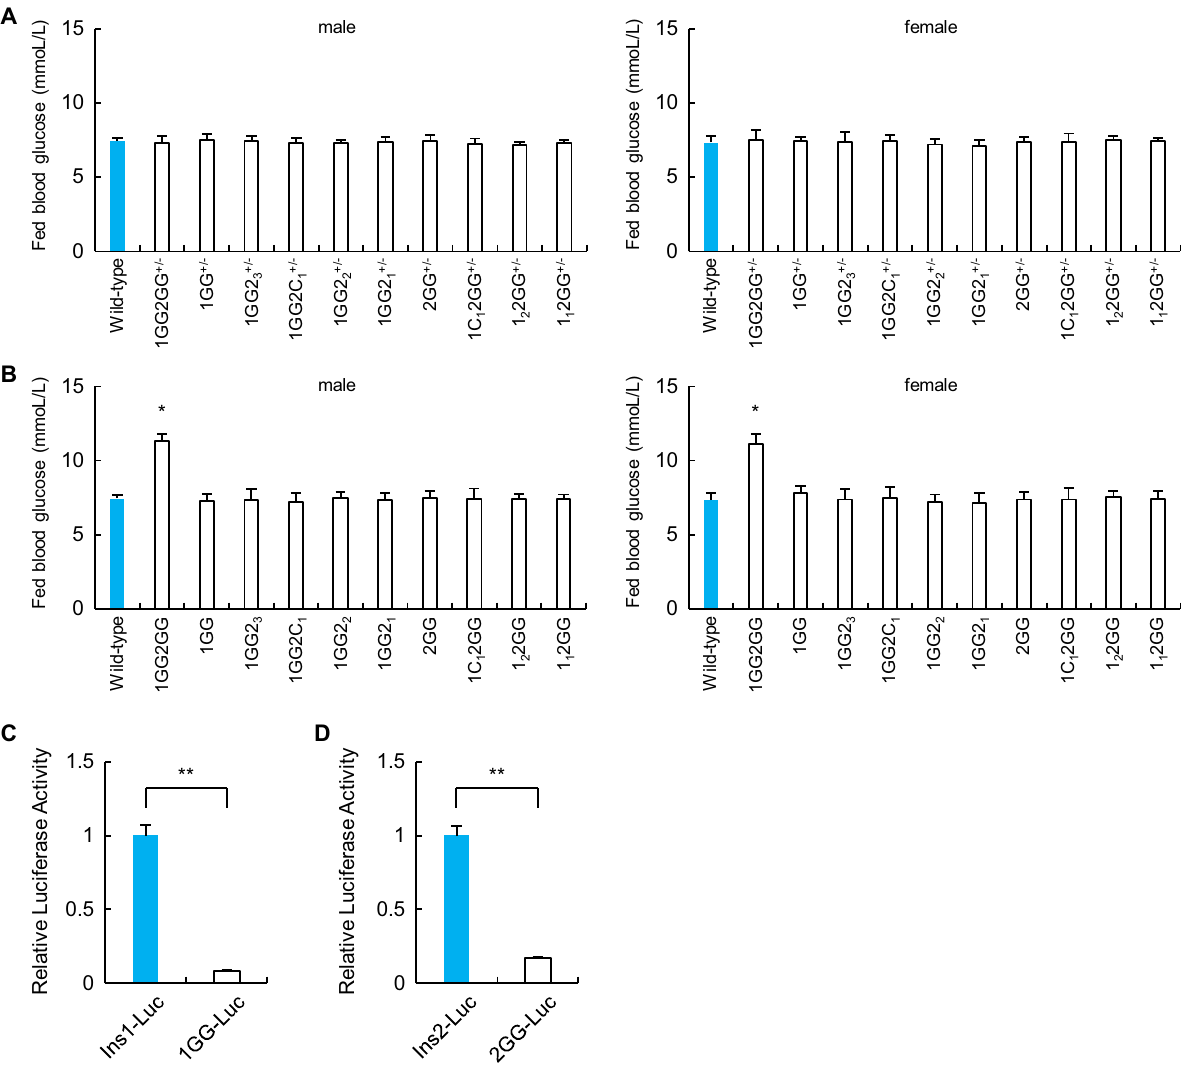
Figure 2. Blood glucose levels of mice with mutations of the insulin promoter and luciferase assay results. ( A ) Blood glucose levels of fed wild-type (n = 6) and heterozygous mice that had deletions in the Ins1/2 promoters (n = 6 each) at 12 weeks of age. ( B ) Blood glucose levels of fed wild-type (n = 6) and homozygous mice that had deletions in the Ins1/2 promoters (n = 6 each) at 12 weeks of age. ( C ) Mouse Ins1 promoter-luciferase plasmid containing approximately 1000 bp of the 5 ′ -flanking sequences of the wild-type or mutated Ins1 promoter region was transfected into βTC6 cells (β-cell line). Forty-eight hours after transfection, cells were harvested and assayed (n = 3). ** p < 0.01. ( D ) Mouse Ins2 promoter-containing luciferase plasmid containing approximately 1000 bp of the 5 ′ -flanking sequences of the wild-type or Ins2 deletion promoter region was transfected into βTC6 cells (β-cell line). Forty-eight hours after transfection, cells were harvested and assayed (n = 3). ** p < 0.01. The error bars represent the standard